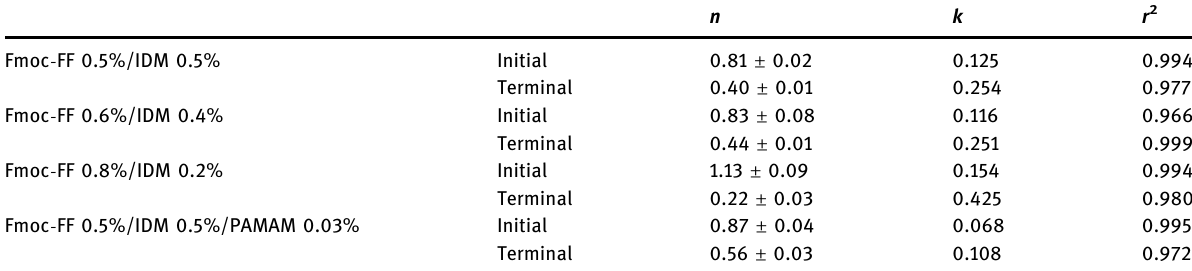
Table 1: Values of n , k , and r 2 obtained by fi tting the in vitro release data with Eq. ( 1 )